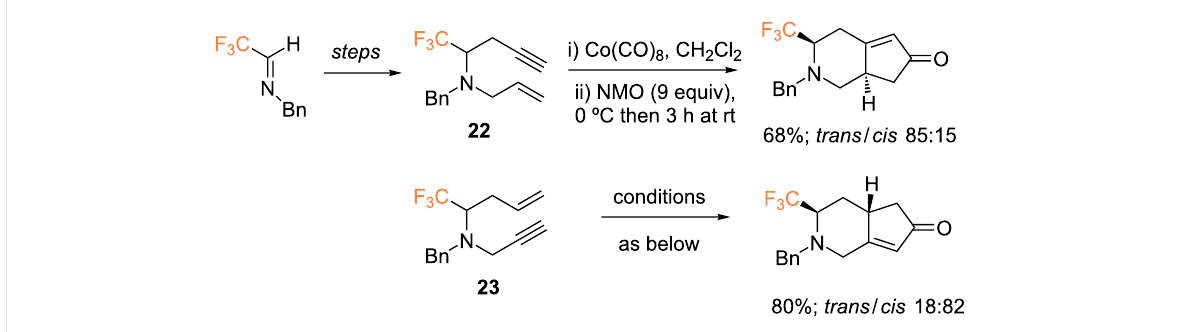
Scheme 10: Intramolecular PKR of 1,7-enynes by the group of Bonnet-Delpon [49]. Reaction conditions: i) Co(CO) 8 (1.2 equiv), CH 2 Cl 2 , 30 min; ii) NMO (9 equiv), 0 °C then 3 h at rt.